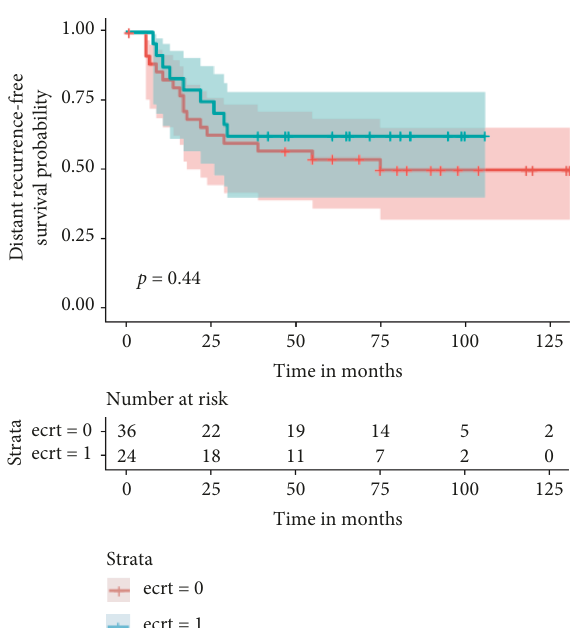
Figure 2: Kaplan-Meier curves showing distant recurrence-free survival stratified by use of reimplantation. Green line with reimplantation of tumor bone and the red without. Time is in